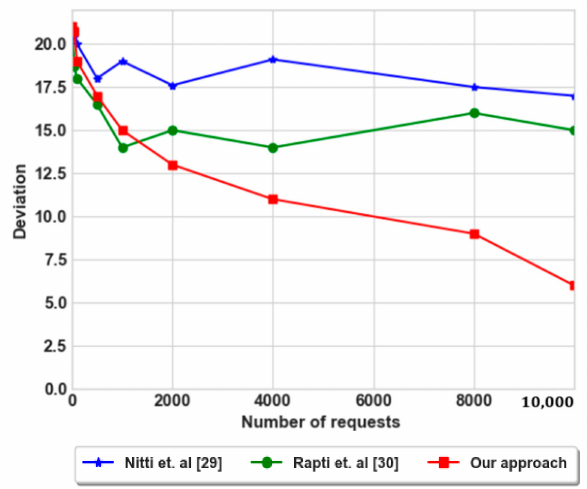
Figure 13. The deviation of residual energies in the social